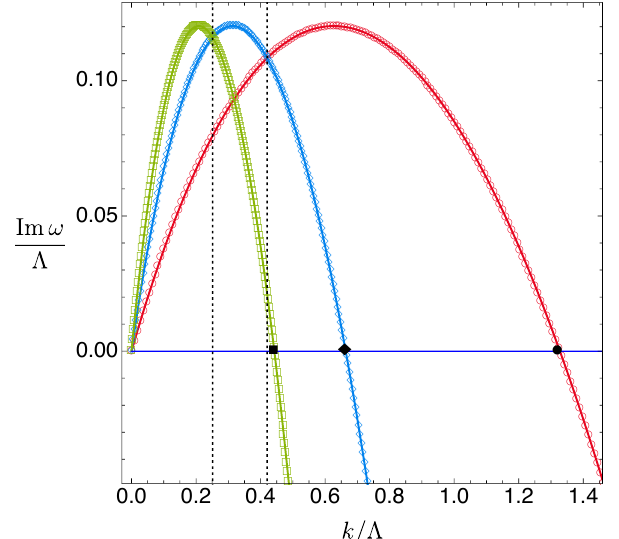
Figure 21 . Dispersion relation of GL modes for a uniform brane with (ˆ τ, ˆ E ) ’ (0 . 395894 , 0 . 867966) . Red circles, blue diamonds and green squares correspond to harmonics with η = 1 , 2 and 3, respec- tively. For reference the maximum of the instability occurs for (ˆ τ, ˆ k